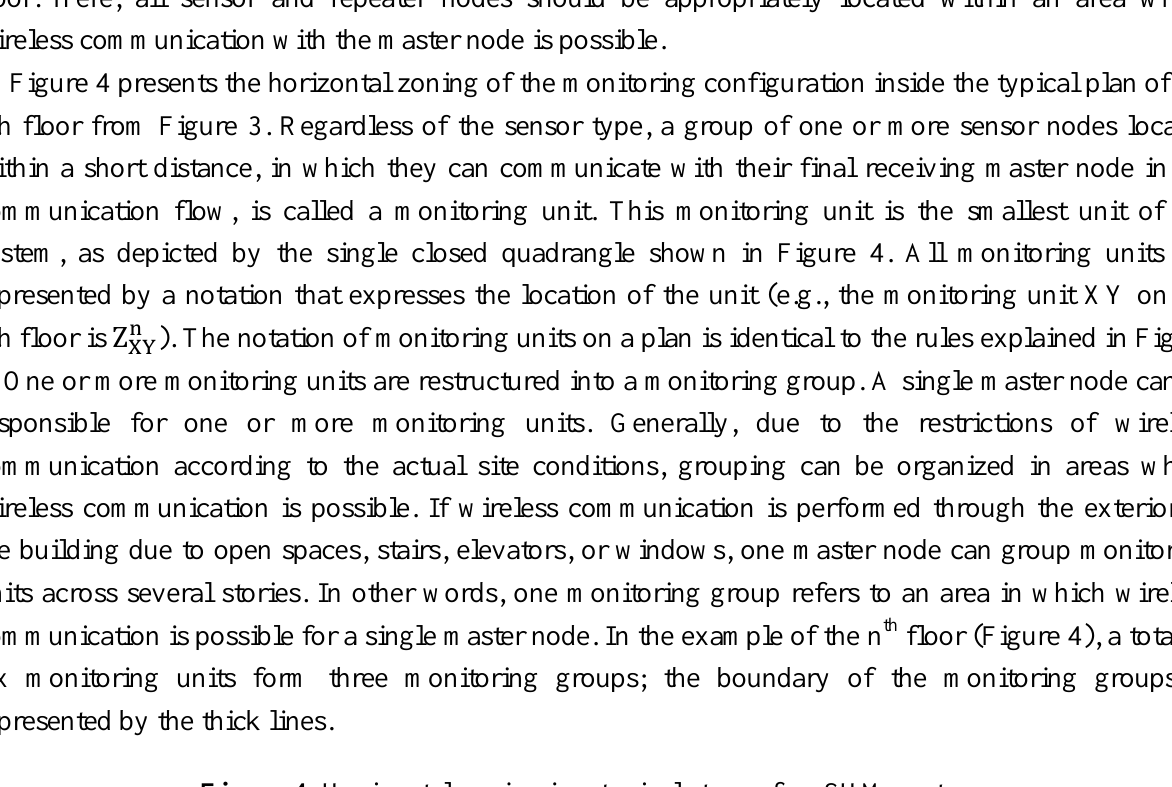
Figure 4. Horizontal zoning in a typical story of an SHM